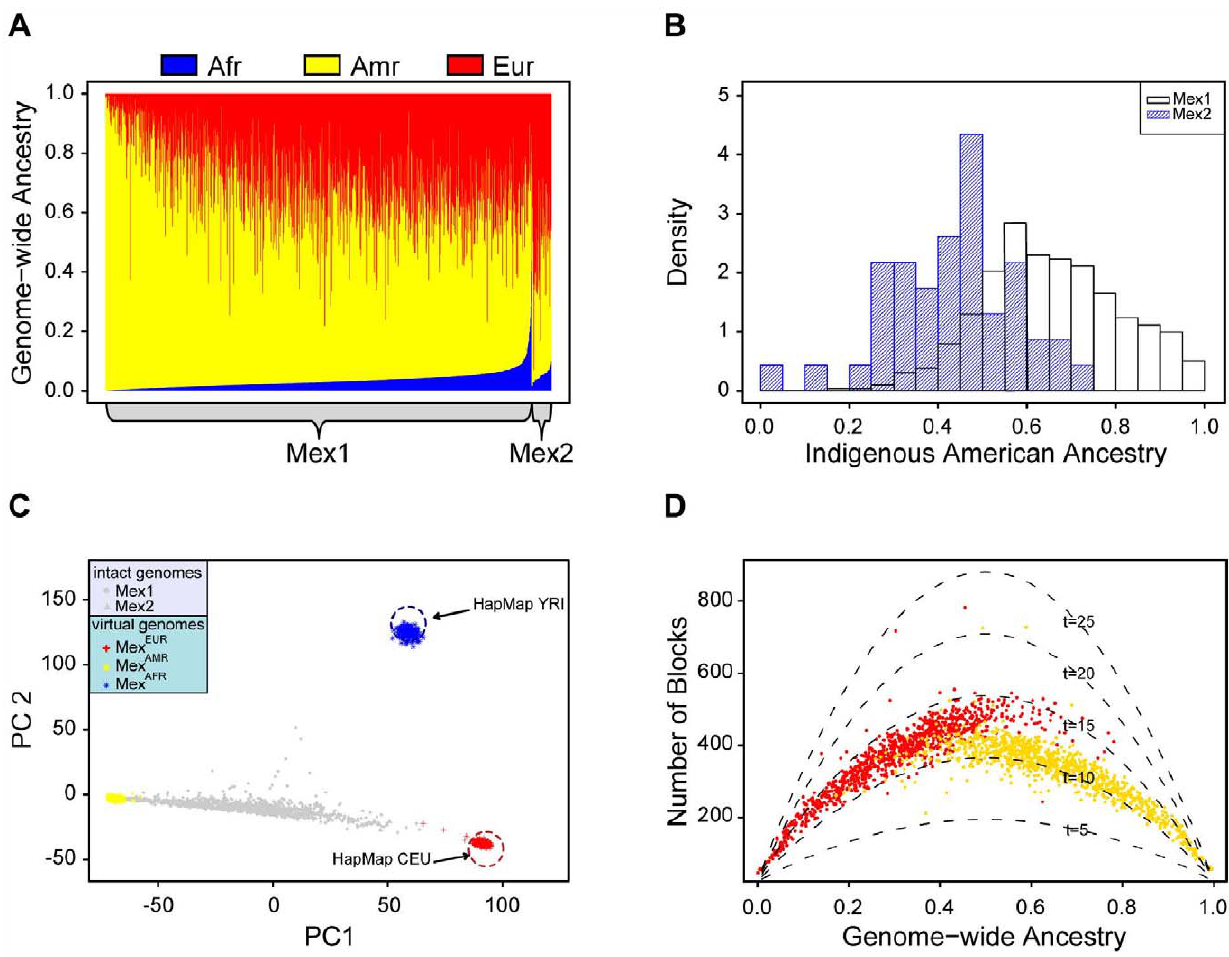
Figure 2. Continental-level ancestry proportions and admixing time. (A) Individual ancestry proportions (red=European; yellow=- Indigenous American, blue=African). (B) Histogram comparing the Indigenous American ancestry in the Mexico City cohort (Mex1) and Los Angeles cohort (Mex2). (C) Principal component analysis of the Mexican individuals from Mexico City and Los Angeles, CA. Red and blue circles indicate the location of the HapMap CEU and YRI individuals, respectively. Gray points represent admixed individuals; virtual genomes, Mex AMR (yellow), Mex EUR (blue) and Mex EUR (red) are projected to the PC plot. (D) Admixing times estimated by the number of ancestry blocks. The number of European (vs non-European) ancestry blocks is plotted against European ancestry (red); analogously, the numbers of Indigenous American (vs non-Indigenous American) blocks are plotted against the Indigenous American ancestry (yellow). Each curve represents the expected number of such blocks for a specific admixing time (in